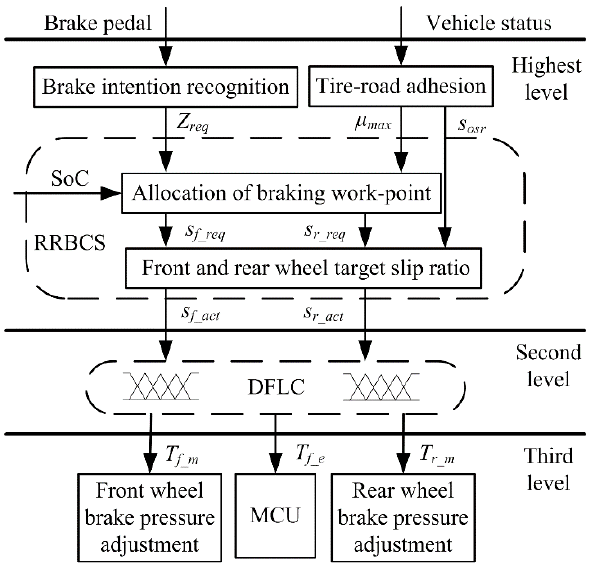
Figure 2. Control level of the revised regenerative braking control strategy (RRBCS).